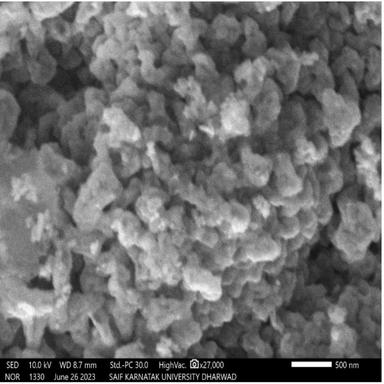
SEM Micrographs of ZnFe(2-x)LuxO4, where x = 0.01(Lu 0.01), 0.03(Lu 0.03), 0.05(Lu 0.05), 0.07(Lu 0.07).